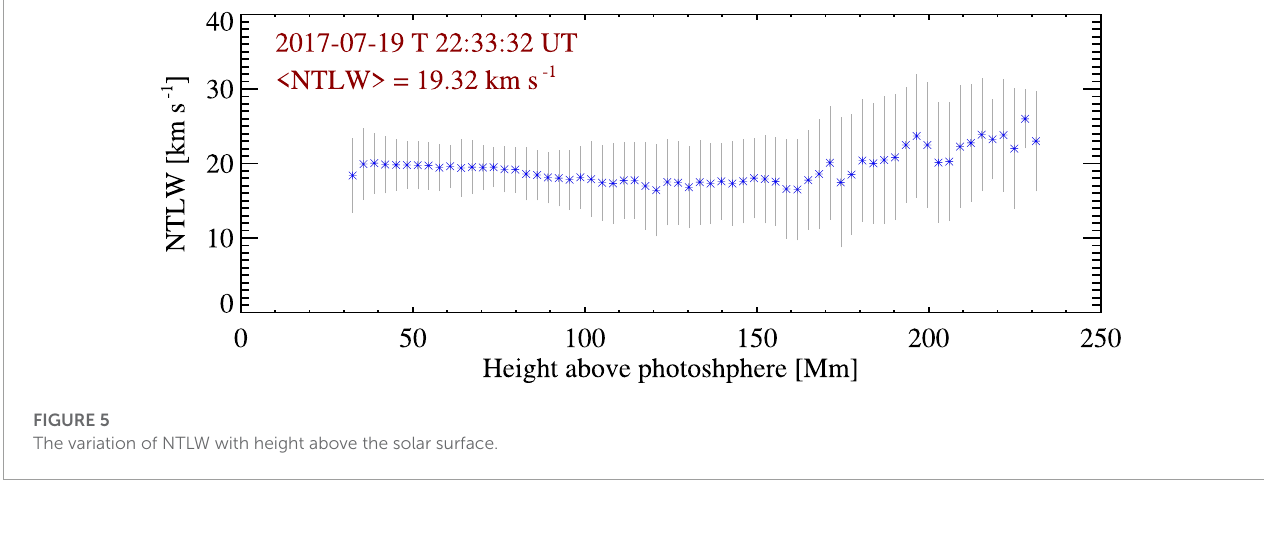
FIGURE 5 The variation of NTLW with height above the solar surface.